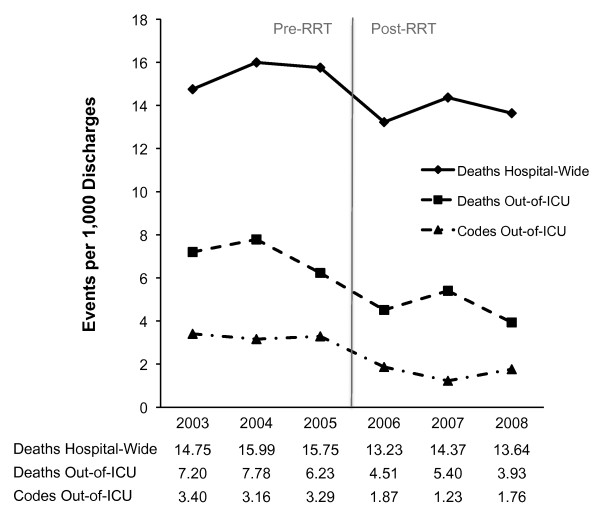
Annual mortality and cardiopulmonary-arrest code rates before and after rapid response team (RRT) implementation. The preintervention period was January 1, 2003, through December 31, 2005. The postintervention period was January 1, 2006, through December 31, 2008. The RRT was introduced over a 6-month period beginning January 2006. Patients admitted throughout introduction of the RRT were included in the postintervention group. Rates of hospital-wide deaths, out-of-ICU deaths, and out-of-ICU codes are provided as events per 1, 000 discharges.